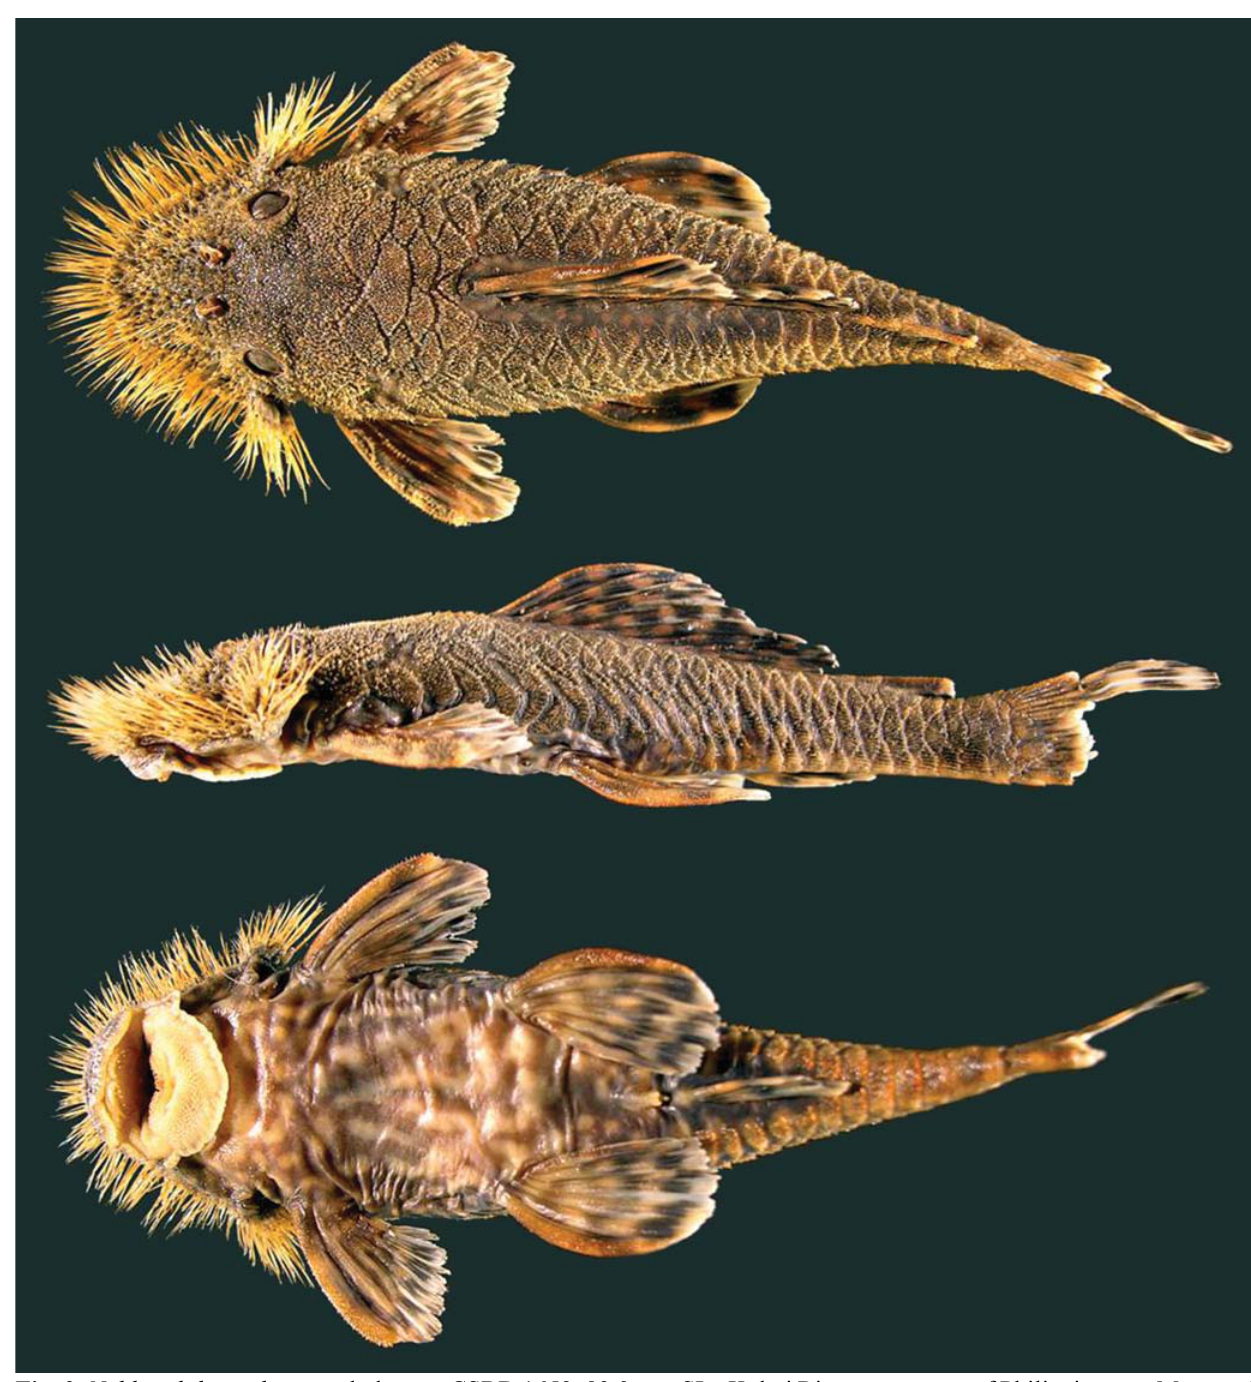
Fig. 3. Neblinichthys echinasus , holotype, CSBD 1652, 82.9 mm SL, Kukui River, near town of Philipai, upper Mazaruni River